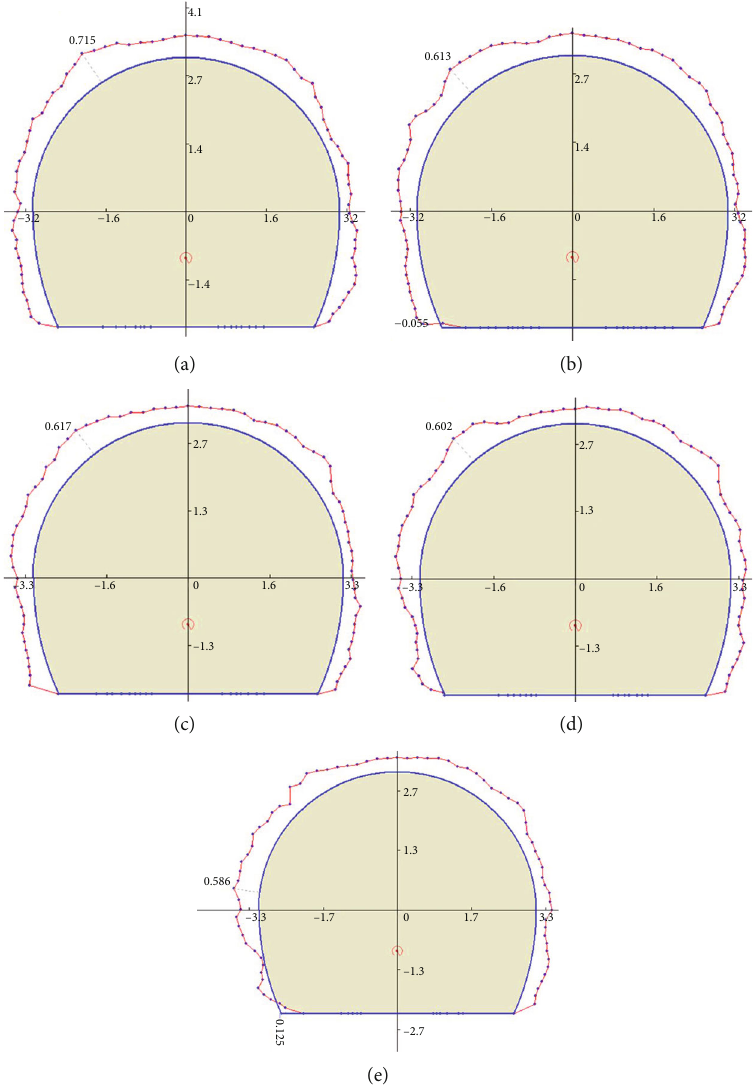
Figure 9: E ff ect of smooth blasting in the SSK0 + 712 excavation cycle for (a) surface no. 1, (b) surface no. 2, (c) surface no. 3, (d) surface no. 4, and (e) surface no. 5.